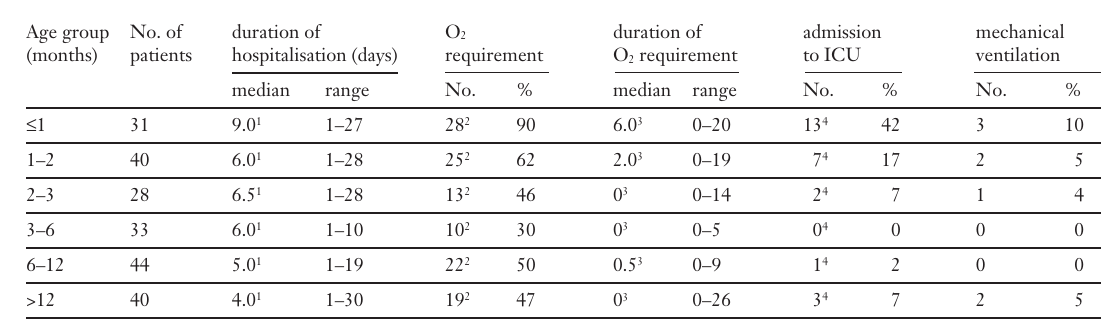
Table 2 Clinical outcome of RSV infection in children of over 35 weeks’ gestational age hospitalised for RSV infection.